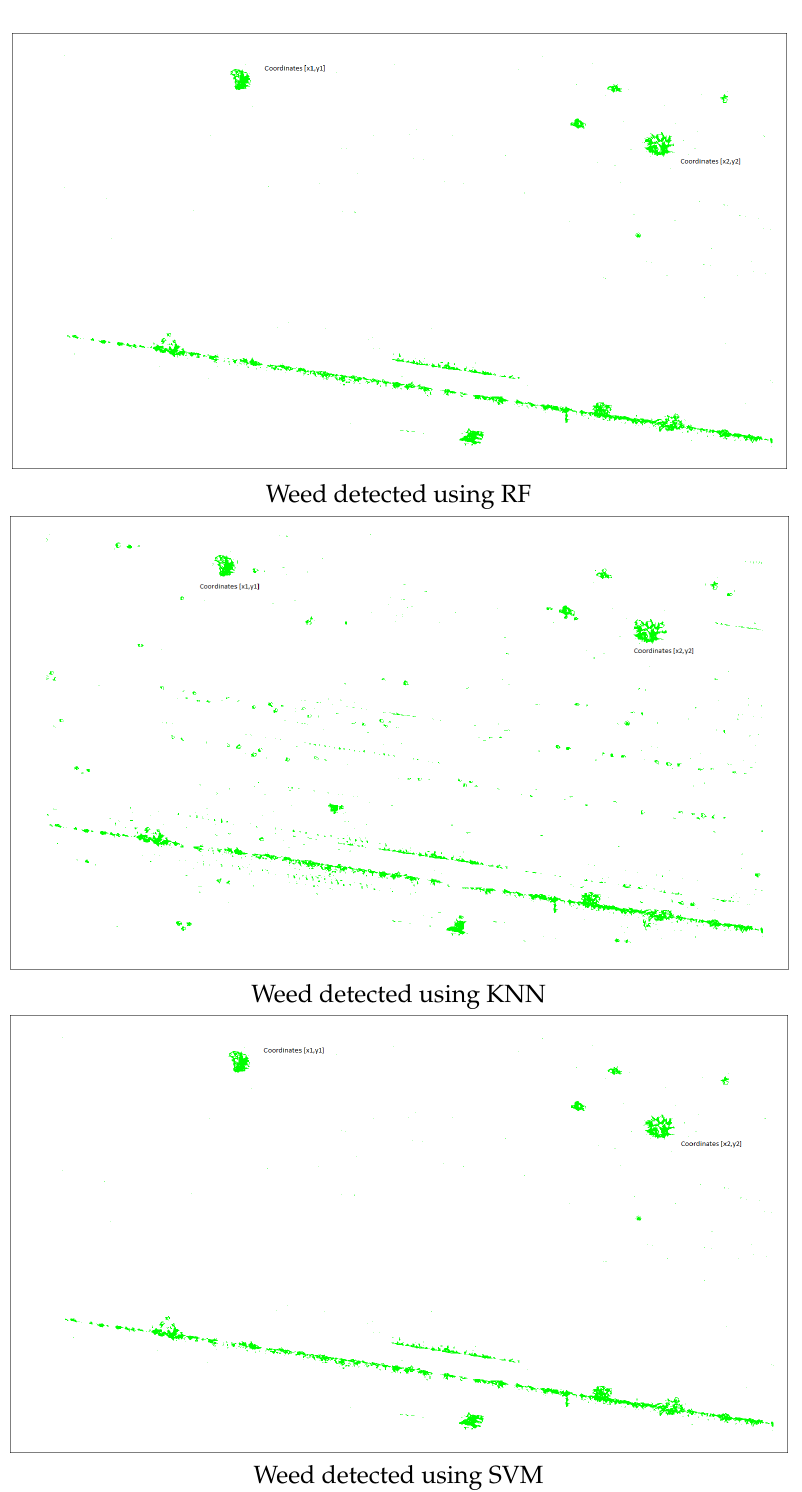
Figure 4. Weed detection using three different machine learning algorithm (RF,KNN, SVM)